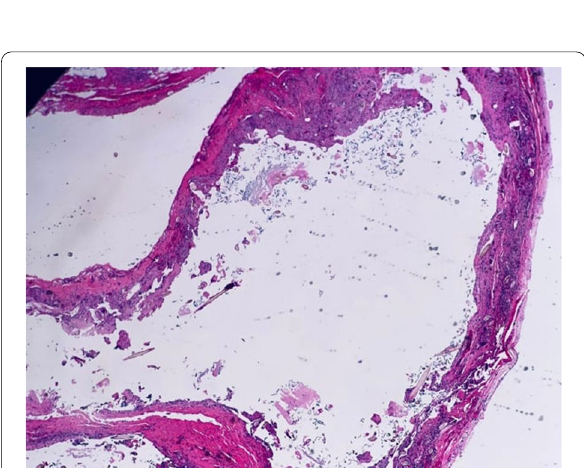
Fig. 4 Hematoxylin and eosin-stained histopathological picture showing a keratin-filled cyst lined by stratified squamous epithelium with a hair